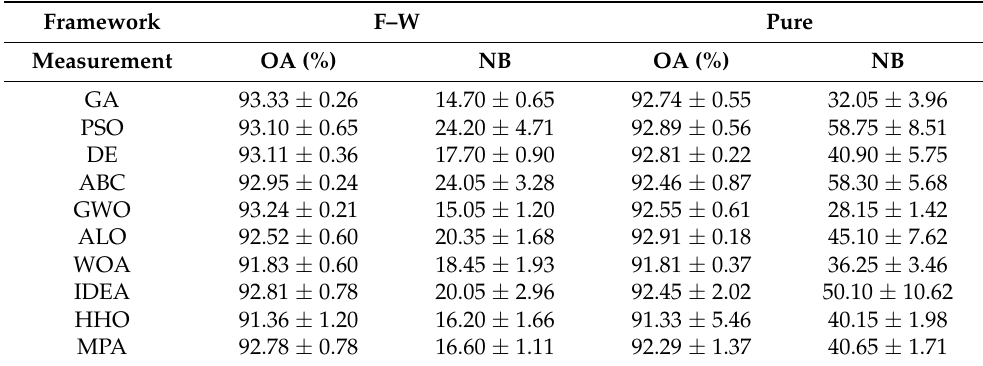
Table 4. The OA and NB of different algorithms on the KSC